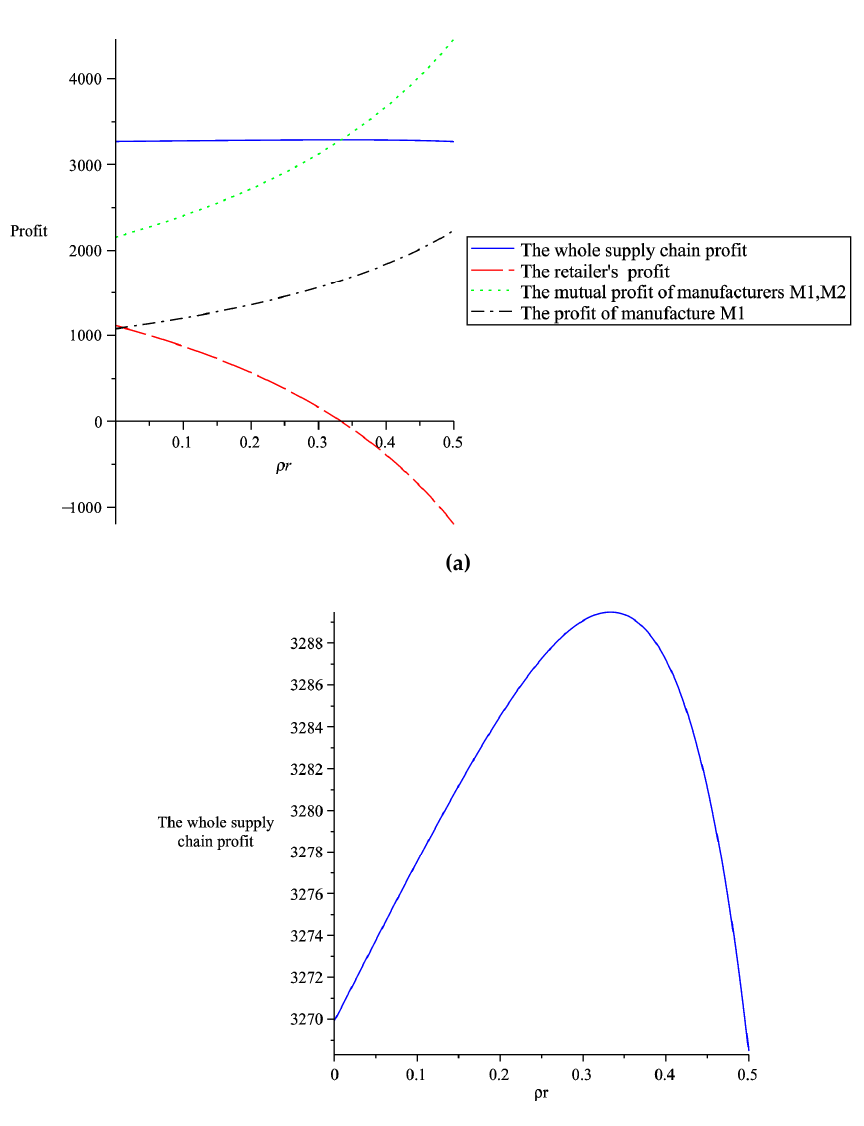
Figure 3. The effect of the retailer’s altruistic preference coefficient on supply chain profits. ( a ) The impact of the retailer’s altruistic preference coefficient on supply chain profits. ( b ) The impact of the retailer’s altruistic preference coefficient on the whole supply chain profit.